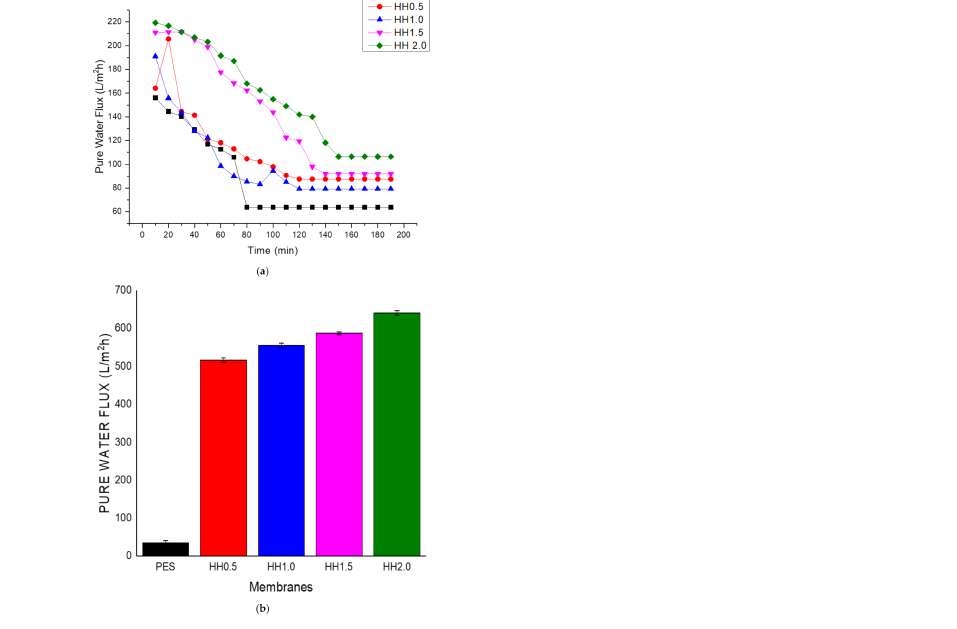
Figure 3. ( a ) Pure water flux (PWF) at different loadings of membrane over time, and ( b ) summary of the final